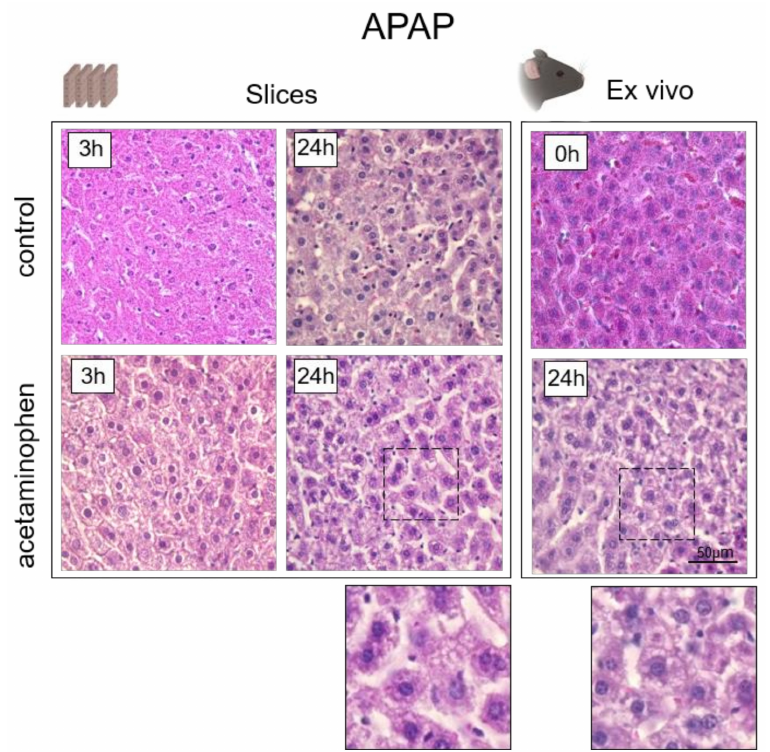
Figure 7. Histological images of liver tissue in the normal state and when exposed to APAP. Hema- toxylin and eosin staining, × 400; scale bar: 50 µ m.